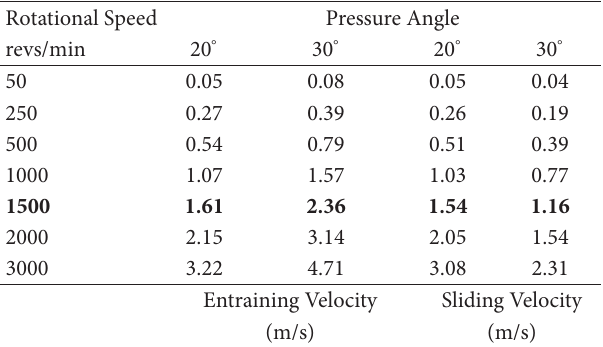
F 6: Variation in minimum �lm thicknesses according to applied load across the line of